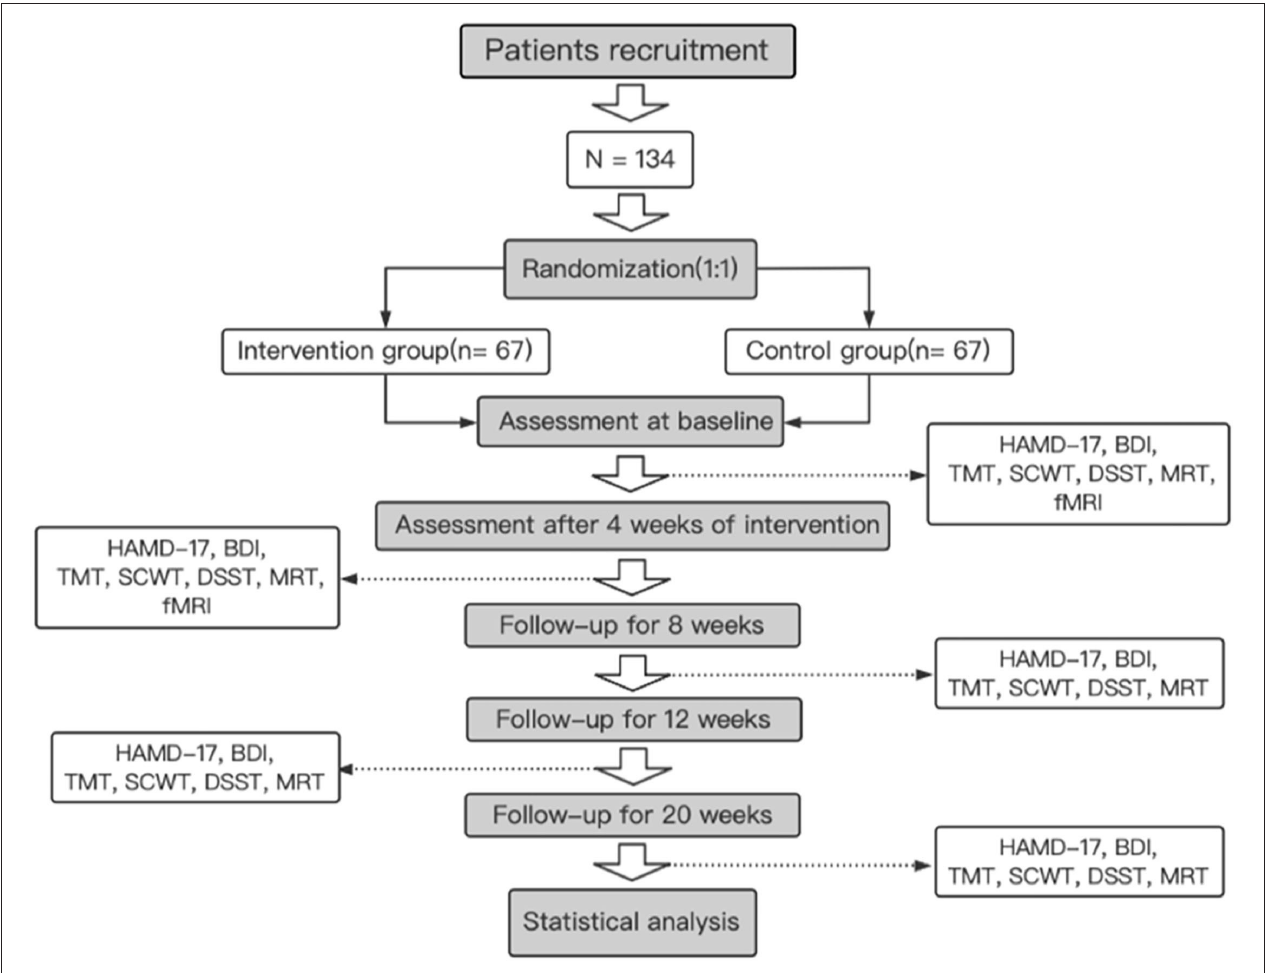
FIGURE 1 | A flow chart of the